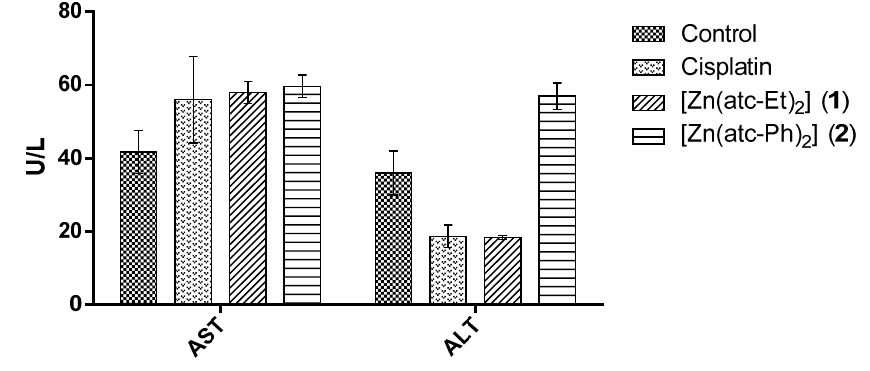
Figure 5. Quantification of the serum aspartate aminotransferase (AST) and alanine aminotransferase (ALT) activity levels in BALB/c mice. U/L: units per liter.